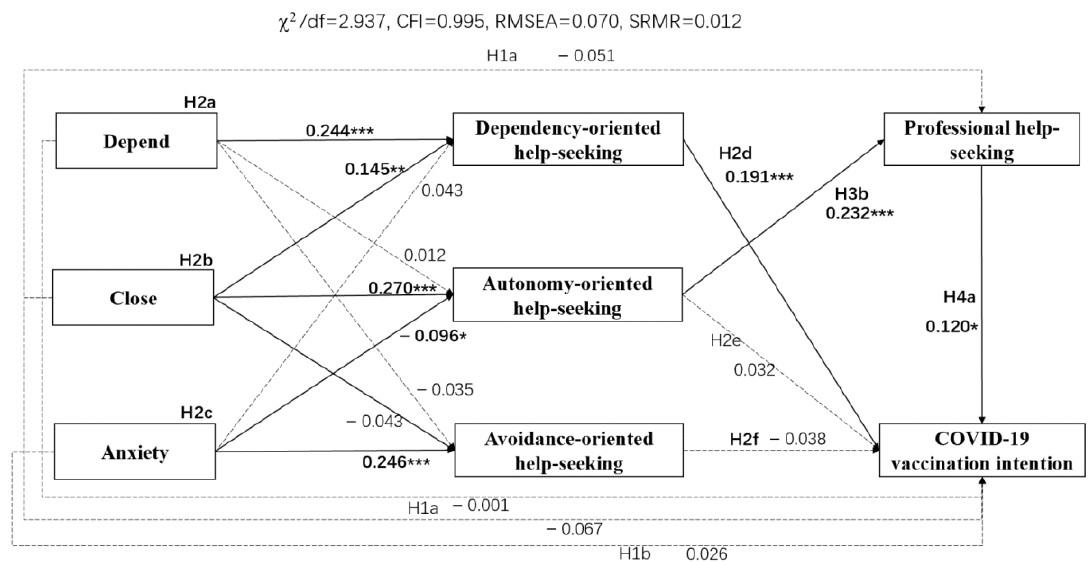
Figure 2. Mediated model 1. N = 401. All coefficients are standardized regression weights. Dotted arrows refer to nonsignificant effects. * p < 0.05. ** p < 0.01. *** p < 0.001.